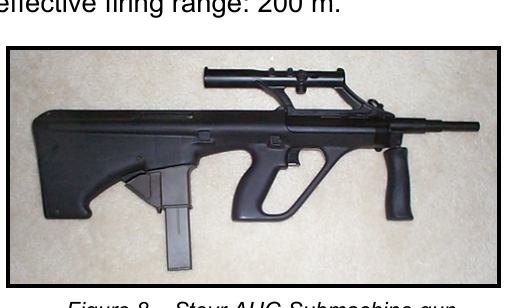
Figure 8 – Steyr AUG Submachine gun Рис . 8 – Автомат Steyr A УГ Слика 8 – Аутомат Steyr